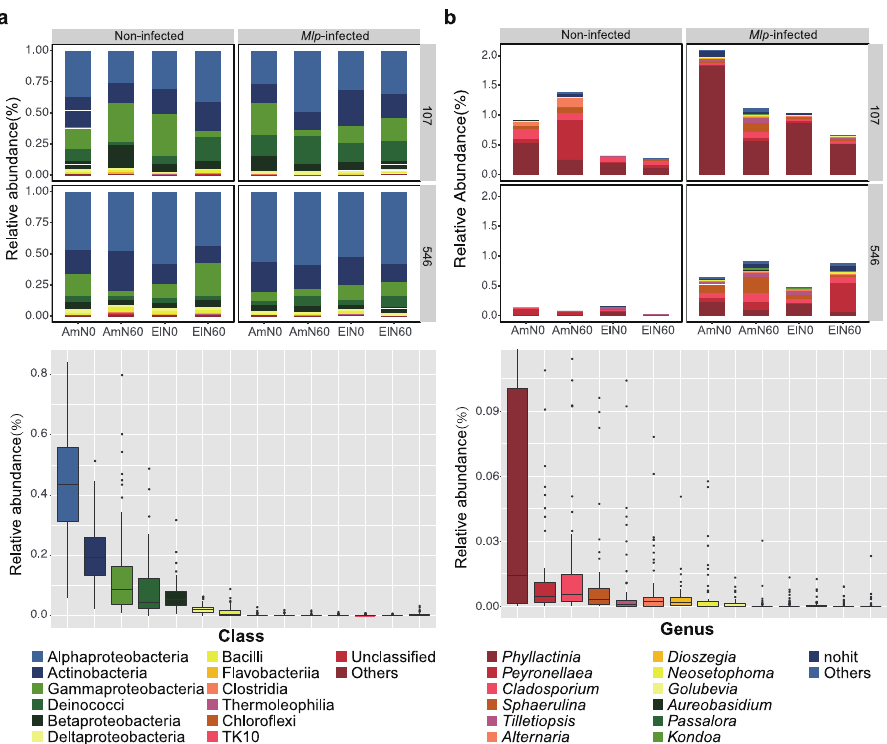
Figure 2. Taxonomic structures of phyllosphere bacterial microbiota at the class level ( a ) and fungal microbiota at the genus level ( b ). Only the 12 families with the largest mean relative abundance are shown.